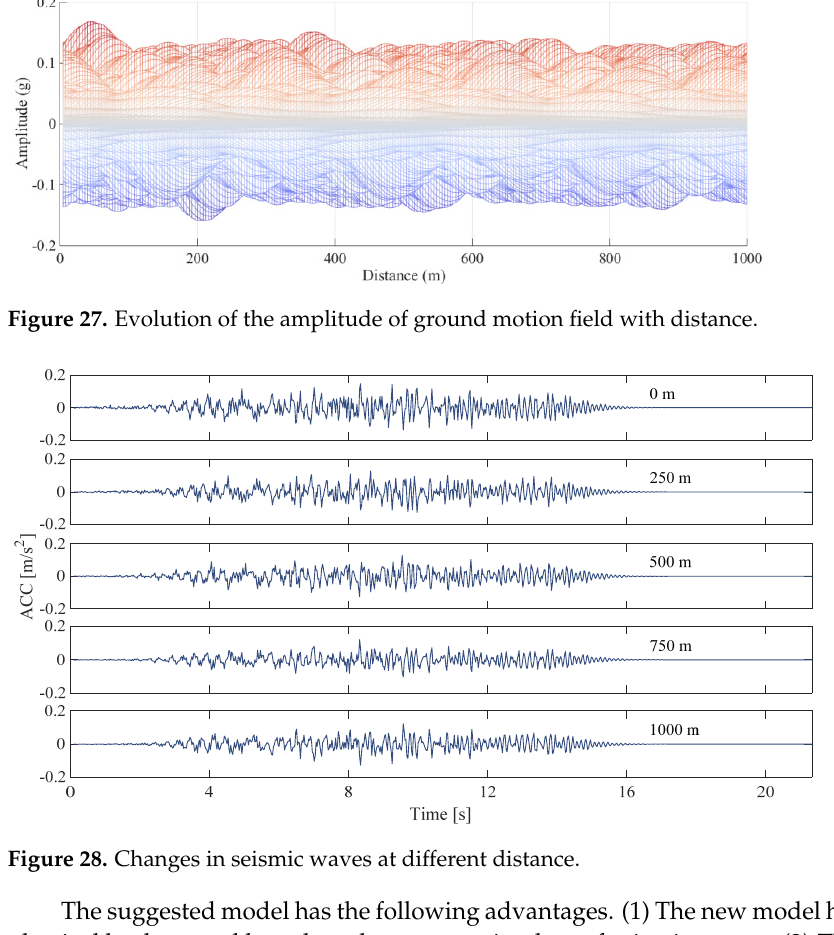
Figure 26. Evolution of the shape of ground motion field with distance.